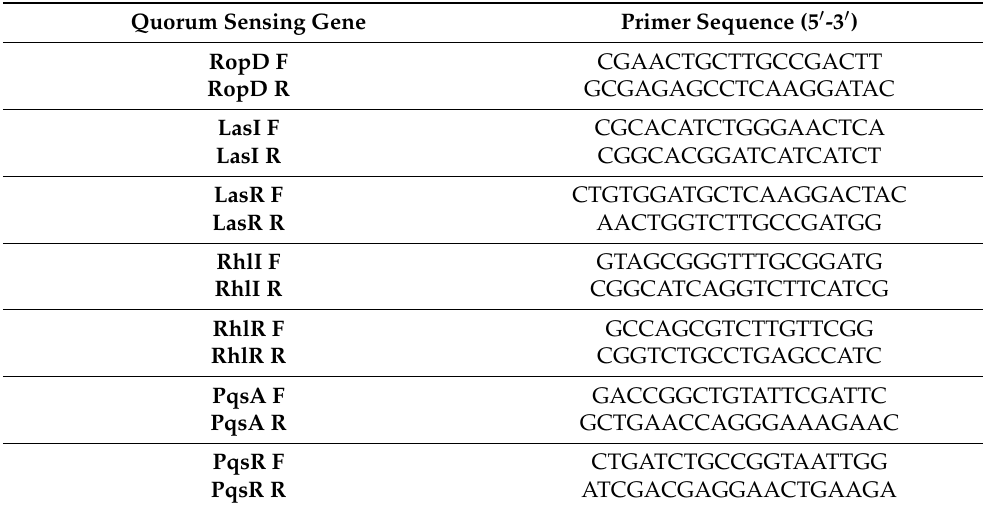
Table 2. Sequence of qPCR primers. Quorum Sensing